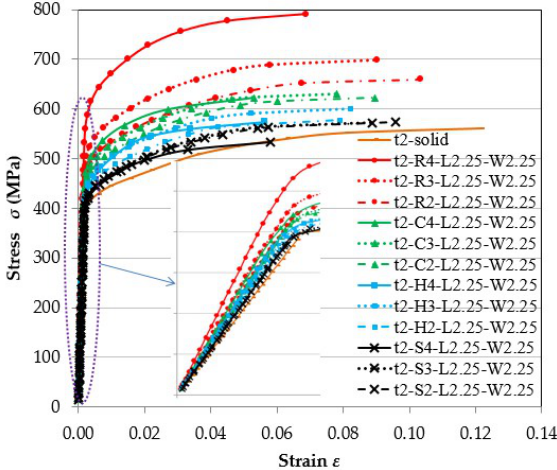
Figure 9. Stress-strain engineering relationships obtained from FE simulation for different perforated steel sheets sizes.